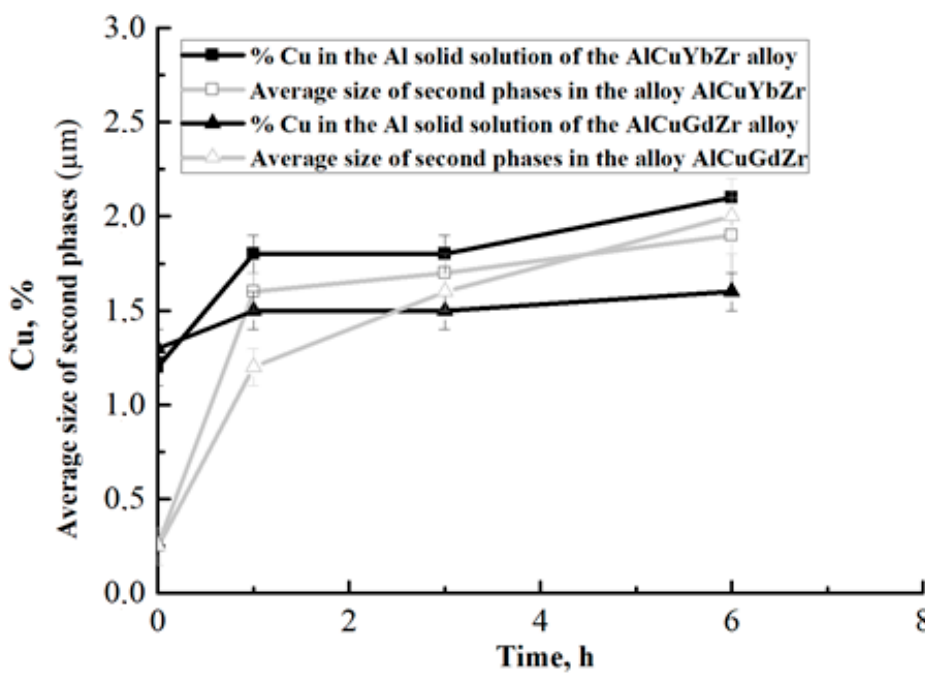
Figure 6. Average sizes of the second phases and copper concentration in the (Al) solid solution.